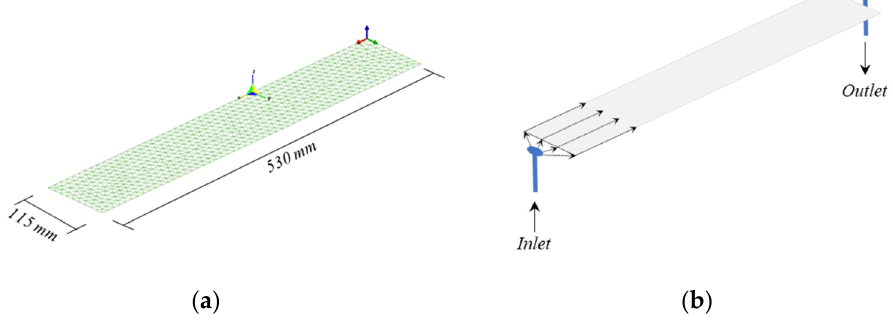
Figure 5. ( a ) Mesh and ( b ) injection strategy used in the simulation.